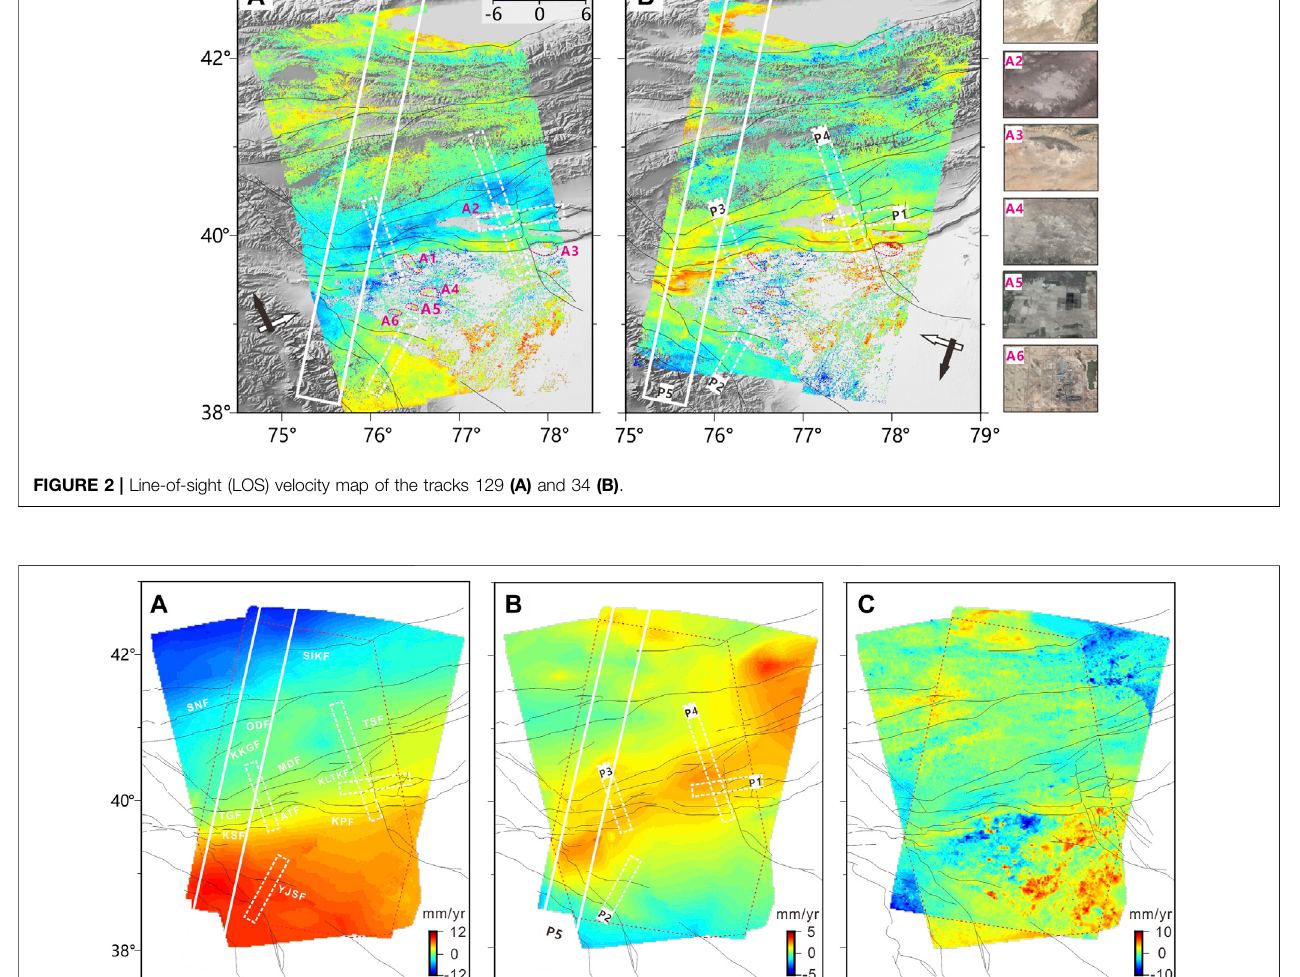
Frontiers in Earth Science |